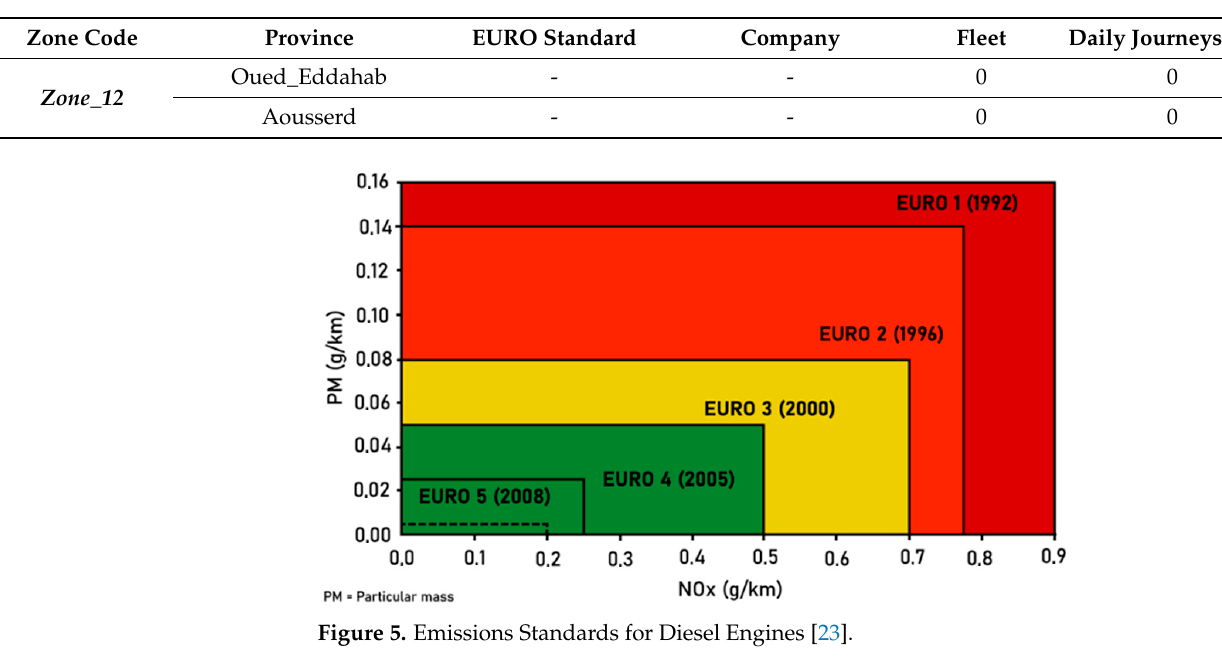
Table 2. Public Bus Fleets Data in Morocco by Province.